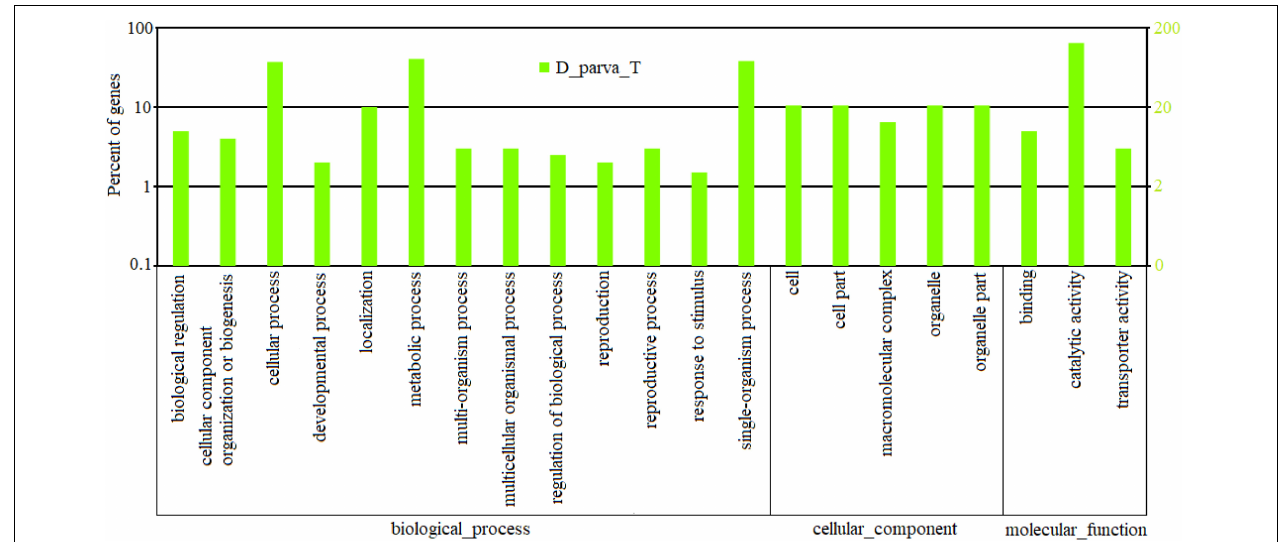
FIGURE 7 | GO classification analysis of peaks in D_Parva_T. GO function is shown in X -axis. The left Y -axis showed the percent of genes which had GO function, and the right Y -axis showed the